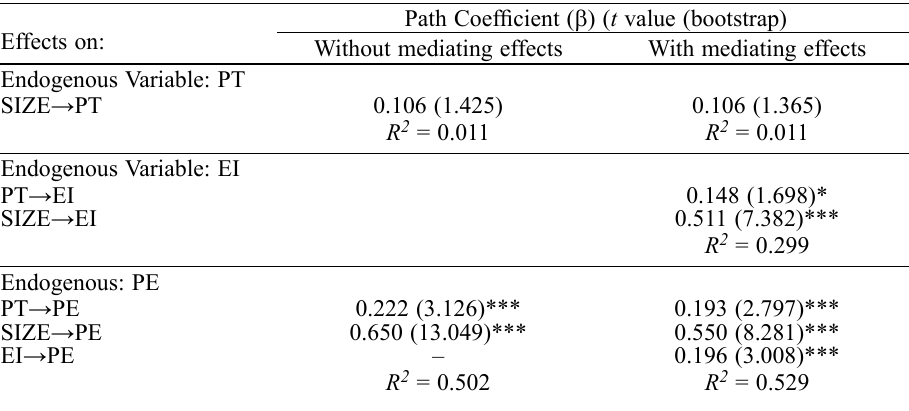
Table 3. Process technology, exports and